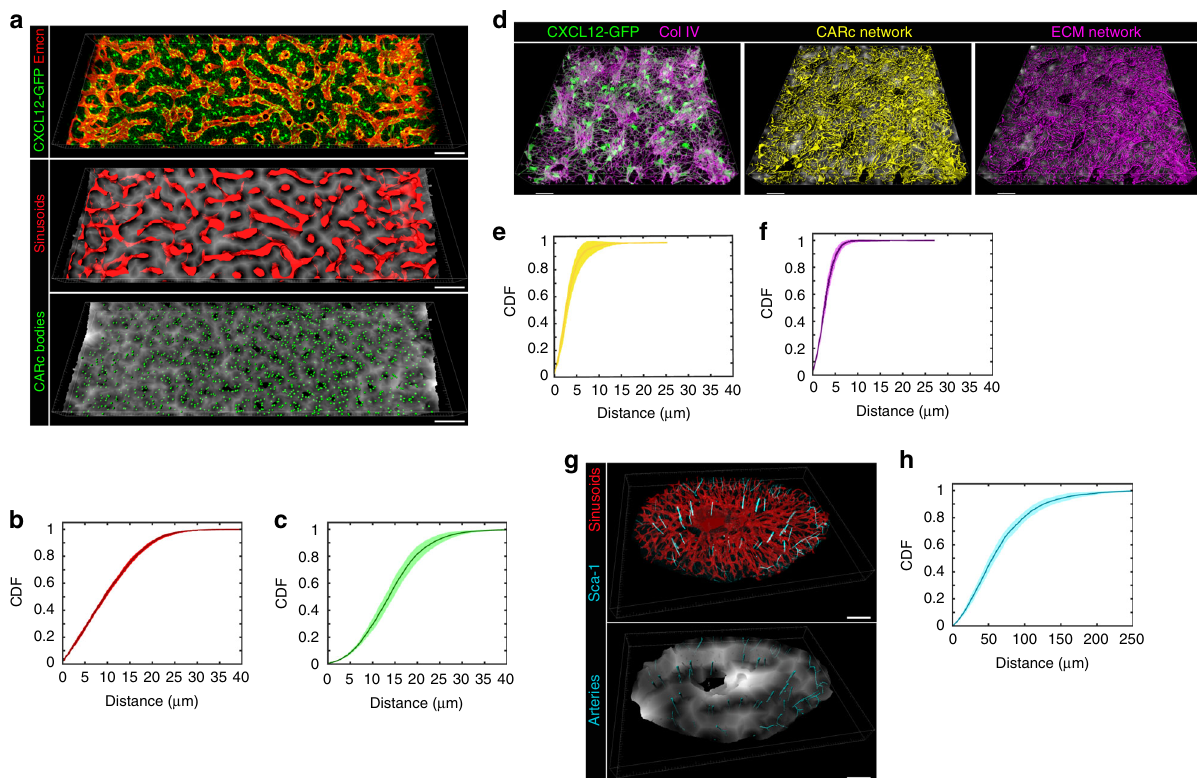
Fig. 5 Spatial coverage of BM spaces by SECs and CARc networks. a Representative examples of BM reconstructions from confocal image stacks (top) employed to automatically segment sinusoids (middle) and CARc bodies (bottom). Scale bar, 100 µ m. The 3D ESD depicts in grey scale the distance from every voxel in extravascular spaces to the closest voxel containing either SECs or CARcs. b , c CDF of ESD to the closest ( b ) sinusoid ( n = 6) and ( c ) CARc soma ( n = 6). d High-resolution 3D reconstructions employed to visualize and segment entire CARc networks (cellular bodies and projections) and ECM fi bres stained with Collagen IV (Col IV). 3D ESD (grey scale) to segmented CARcs (middle) and ECM (right) networks. Scale bars, 30 µ m. e , f Cumulative distribution functions of the ESD to CARcs ( n = 7) ( e ) and ECM ( n = 7) ( f ) networks. g 3D image of a transversal femoral section depicting Sca-1 signal and segmented sinusoids (top). In the bottom panel the arterial Sca-1 signal is segmented and the ESD to arteries is shown in grey scale within the same image. h CDF of the ESD to arteries/arterioles ( n = 5 bones in which data from metaphysis and diaphysis are combined). In b , c , e , f , h , the mean accumulated frequencies at each distance are represented by solid lines, with the standard deviations shown as the